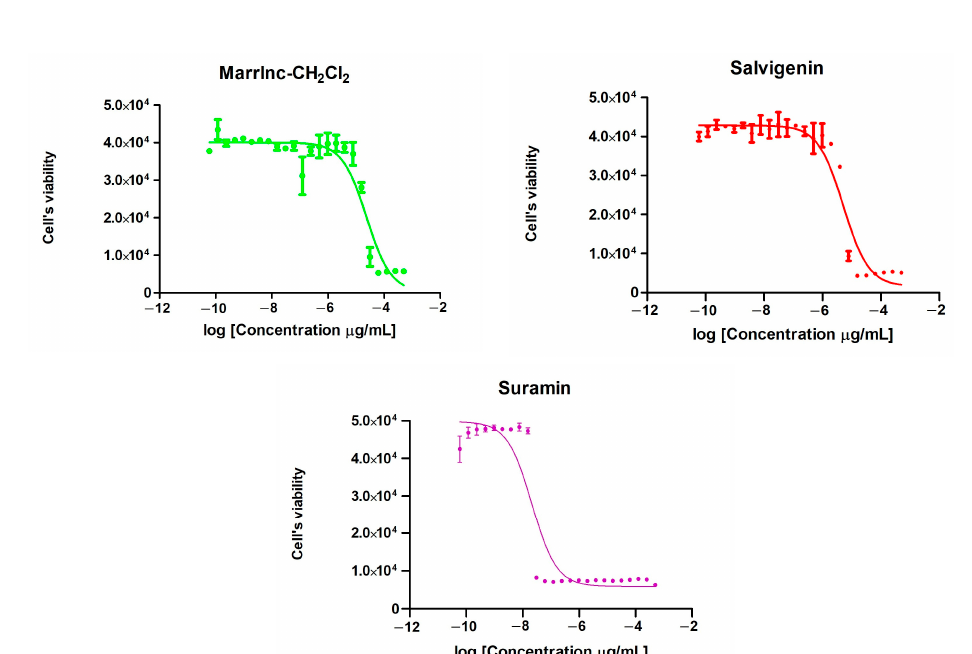
Figure 4. Growth inhibition of T. b . bruceiTC221 cells induced by Marrinc-CH 2 Cl 2 (green), salvigenin (red), and suramin (purple). The graphs show the average results from eightindependent experiments with standard errors.